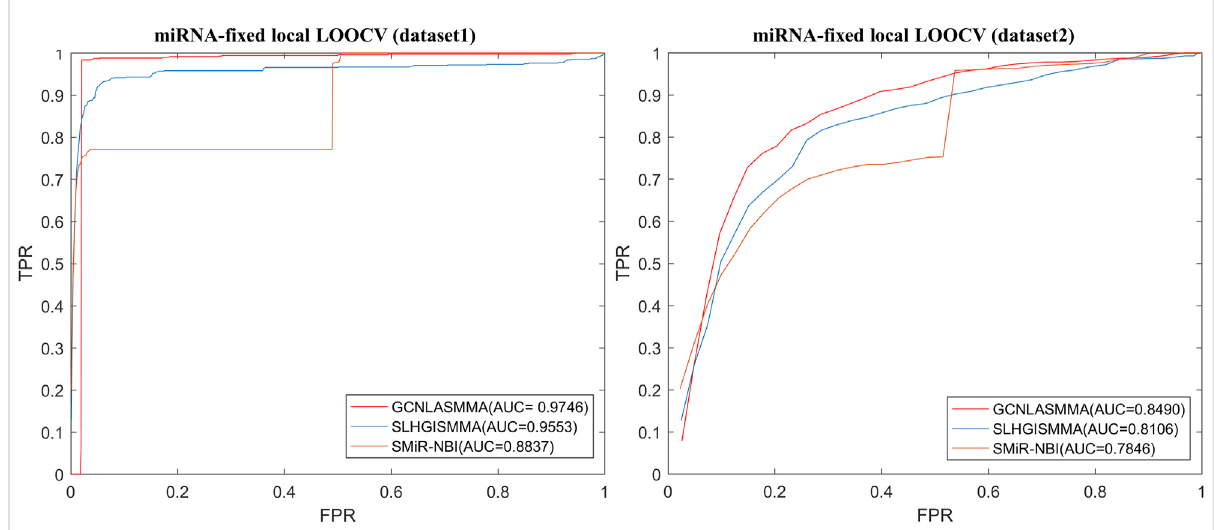
FIGURE 3 The left half of the fi gure shows the comparison of GCNLASMMA with two comparison algorithms under miRNA- fi xed LOOCV based on dataset1. As a result, GCNLASMMA, SLHGISMMA and SMiR-NBI achieve AUCs of 0.9746, 0.9553 and 0.8837, respectively. The right half of the fi gure shows the comparison of GCNLASMMA with two comparison algorithms under miRNA- fi xed LOOCV based on dataset2. As a result, GCNLASMMA, SLHGISMMA and SMiR-NBI achieve AUCs of 0.8490, 0.8106 and 0.7846, respectively.